Question: Summarize what this figure shows in one sentence.
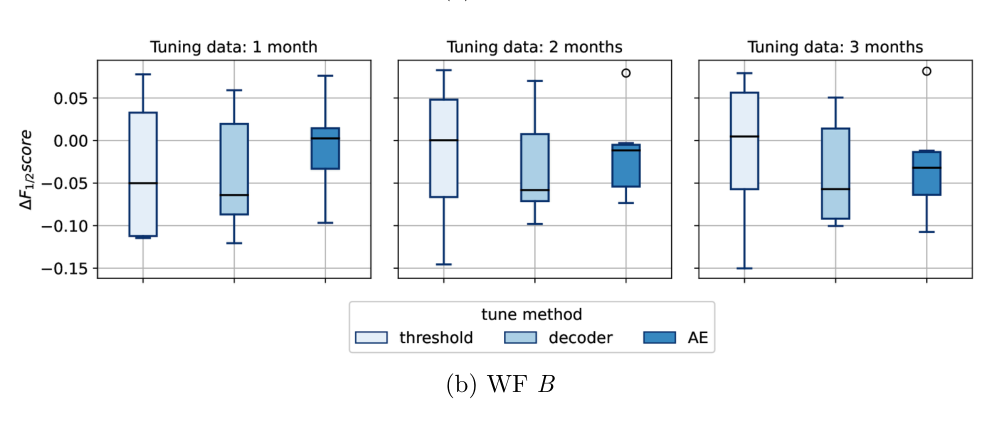
Answer: Transfer Learning results using data of multiple assets to train a source model and fine-tuning on the target wind turbine. The difference in F1/2 score with respect to the baseline model for each wind turbine is shown.